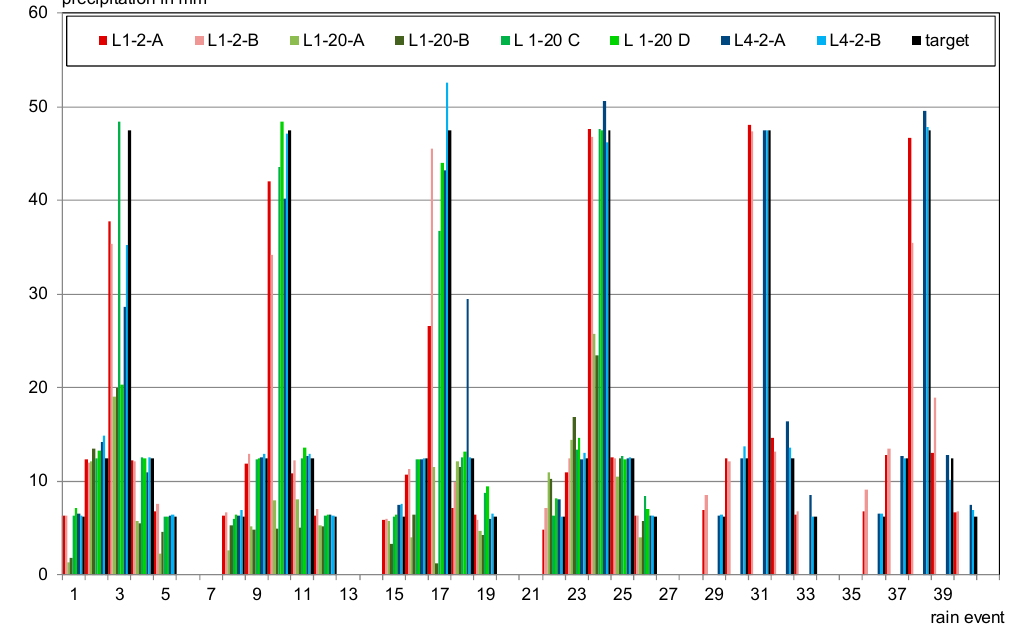
Figure 9. Wetting cycle for the laboratory irrigation.